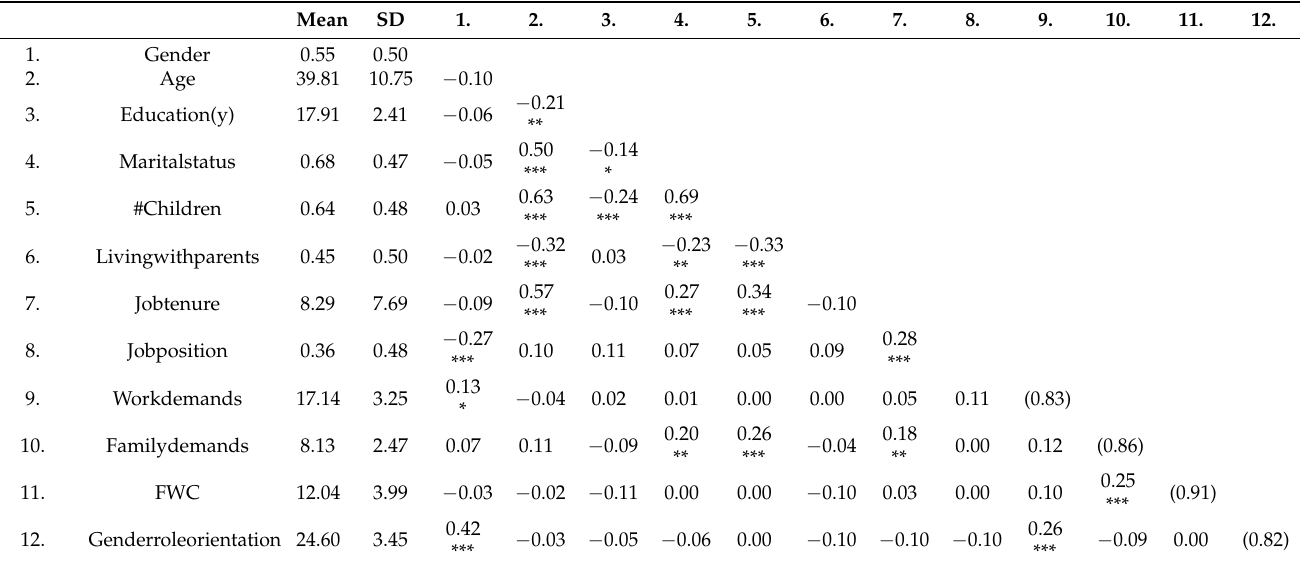
Table 2. Interrelations among research variables (N =